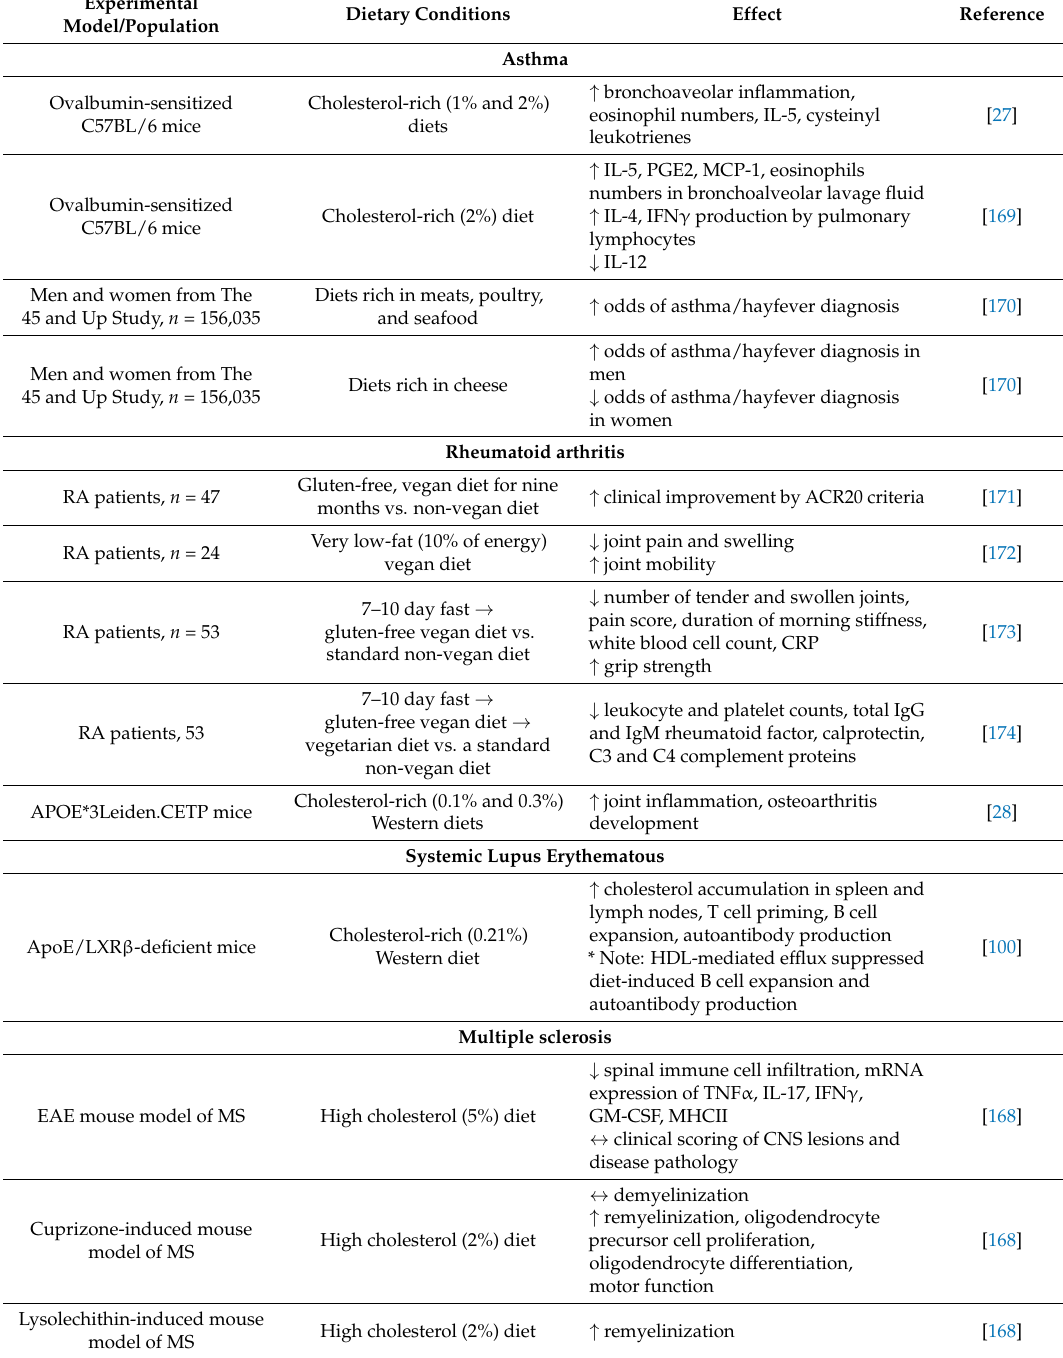
Table 3. Differential effects of dietary cholesterol on the pathophysiology of autoimmune